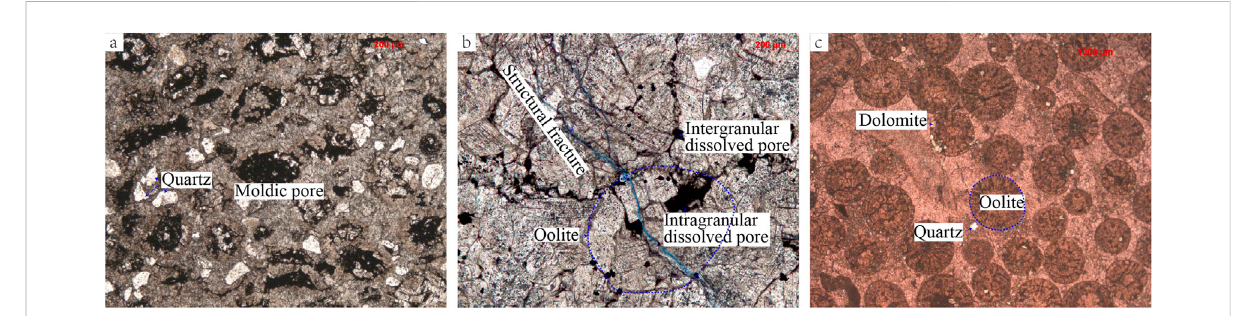
FIGURE 8 Effect of diagenesis on pore development. (A) Strong dolomitization and dissolution, and weak compaction. Sparry oolitic dolomite, Well CT1, 6266.42 m, single polarized light, dyed cast thin section; (B) Strong structural fracture and dolomitization, and pores are relatively developed. Sparry oolitic dolomite, Well DB1, 5947.5 m, single polarized light, dyed cast thin section; (C) Extremely underdeveloped pores, due to strong cementation, weak dolomitization, dissolution, and structural rupture. Sparry oolitic limestone, Well Chongtan 1, 6279.94 m, single polarized light, dyed cast thin